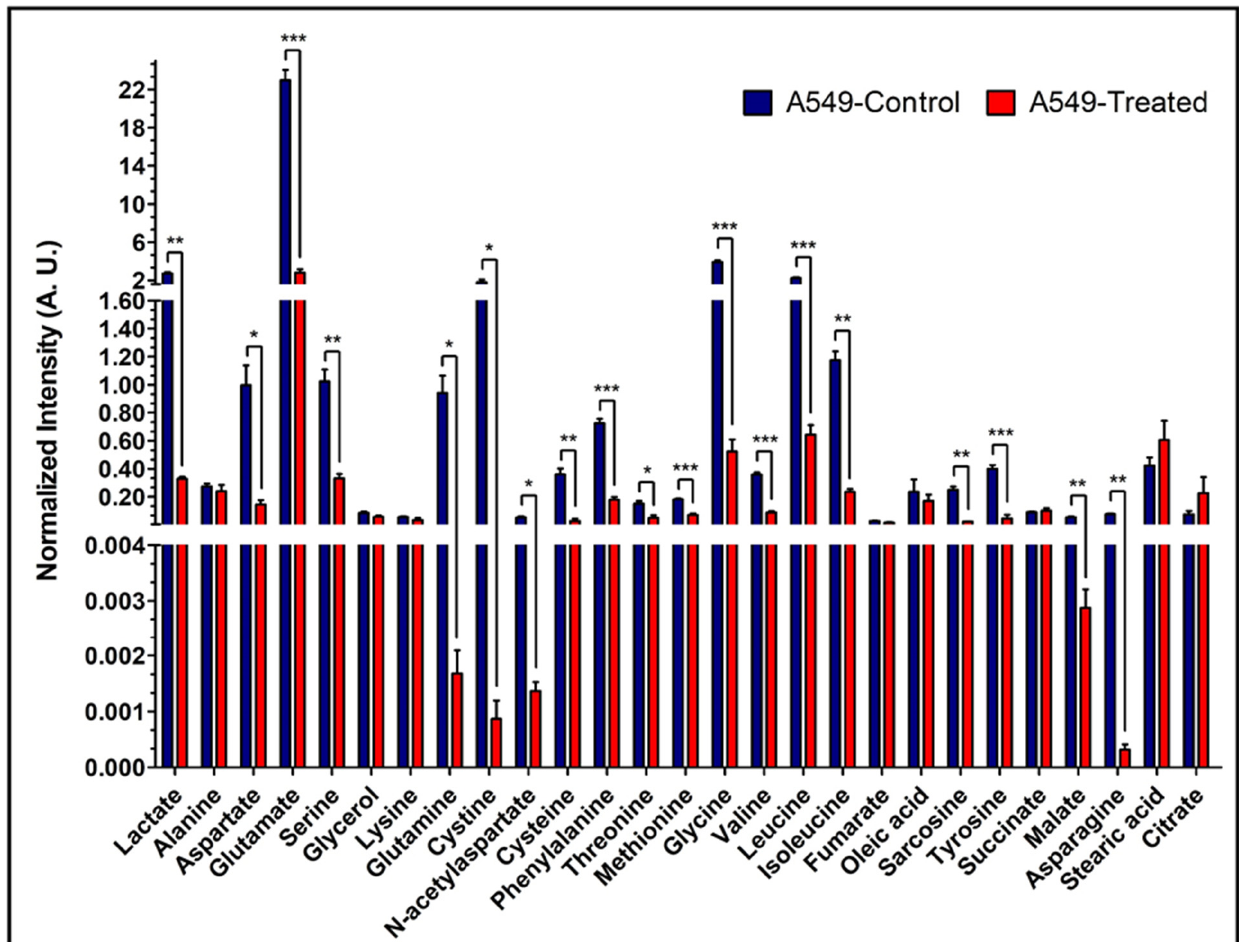
Figure 6. Intracellular levels of the metabolites in A549 cells. Bar plots of GC-MS analysis-based levels of different intracellular metabolites from A549 cells. Shown are the normalized intensities of the differential levels of metabolites between control and treated A549 cells. (Note: N = 3: biological replicate data are represented as mean ± SEM. Student’s t-test was used to calculate statistical significance followed by false discovery rate (FDR) performed in RStudio, to adjust p values and represented as: “*” if p ≤ 0.05, “**” if p ≤ 0.01, and “***” if p ≤ 0.001).